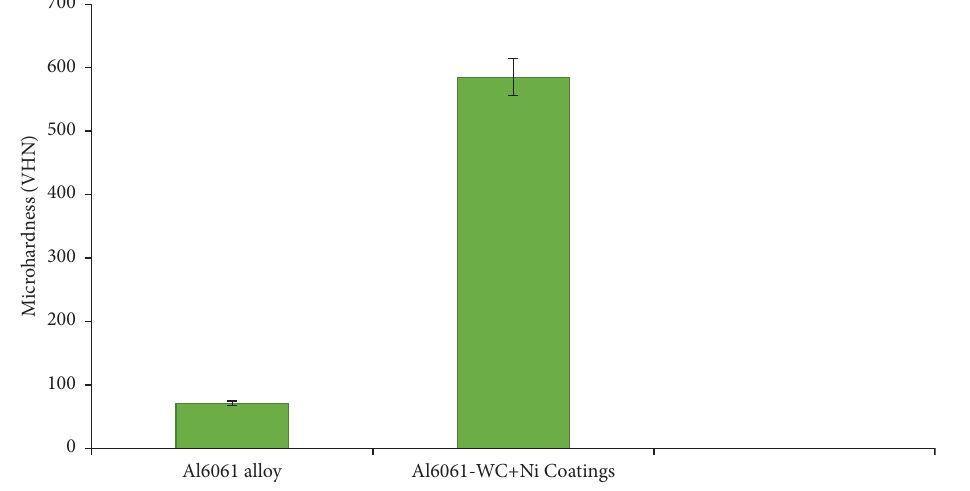
Figure 5: Comparison of hardness between alloy and